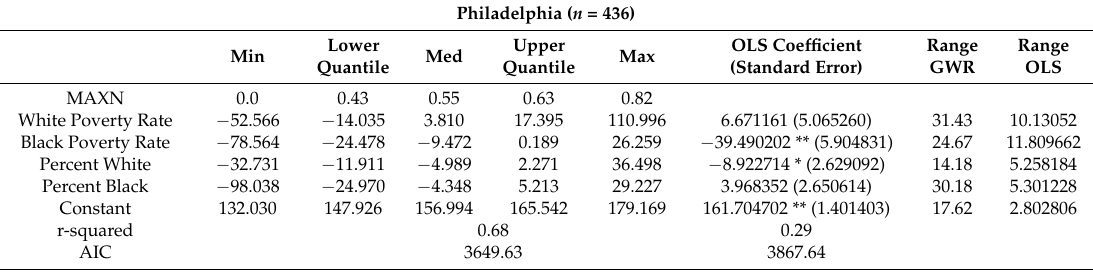
Table 8. Global and Local Parameter Estimates of the Geographically Weighted Regression Model for Philadelphia.